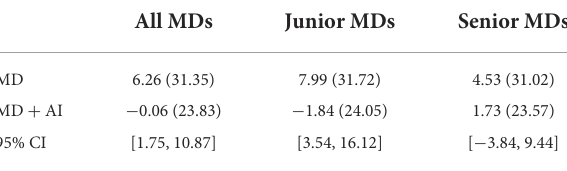
TABLE 5 Mean distance with standard deviation of estimation made by MD and MD + AI, to the prediction of the AI